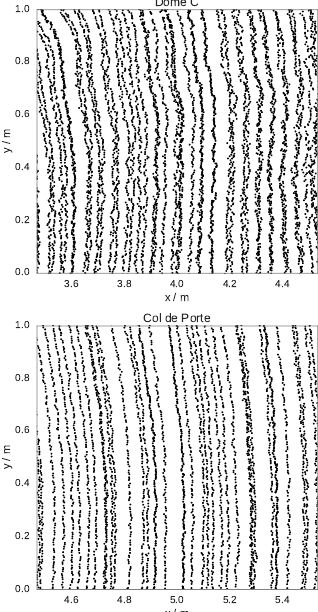
Figure 10. Zoomed image of the scans at Dome C and Col de Porte acquired 15 February 2015. Each point shown in the ( x , y ) plan is an individual measurement of the laser